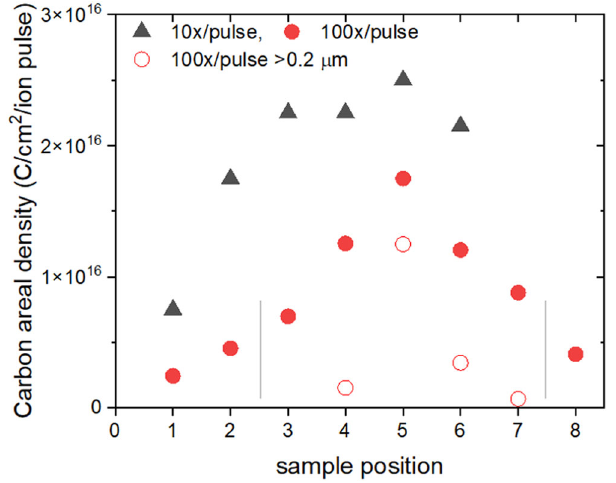
Fig. 6 Carbon areal density near the surface. Line scan of carbon areal density in the top 200 nm for the 10x and 100x pulse samples for the series of NRA spots across the laser-ion beam spot in a 10 mm line scan. For the 100x pulse sample we also show the carbon areal density integrated for depth >200 nm. The concentration and areal density values are normalized to the number of pulses for comparison. The gray lines indicate the initial 5 mm wide opening in the aluminum